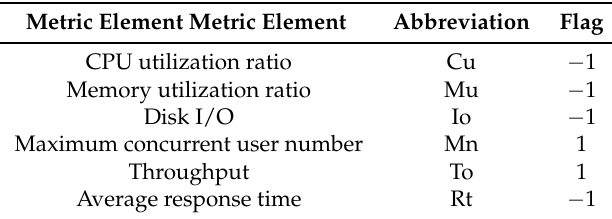
Table 1. The flags of metric